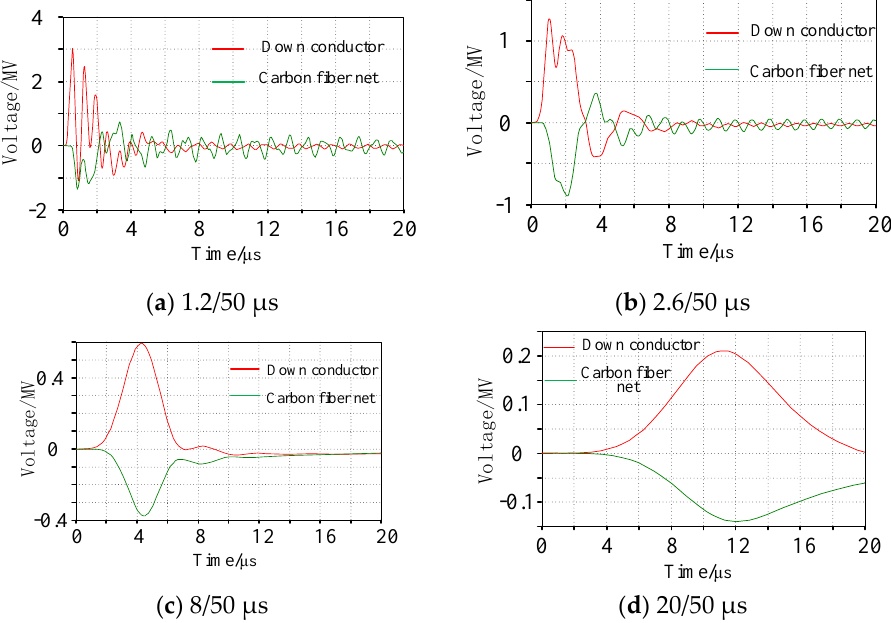
Figure 7. Overvoltage of down-conductor and the CFN at different front times.